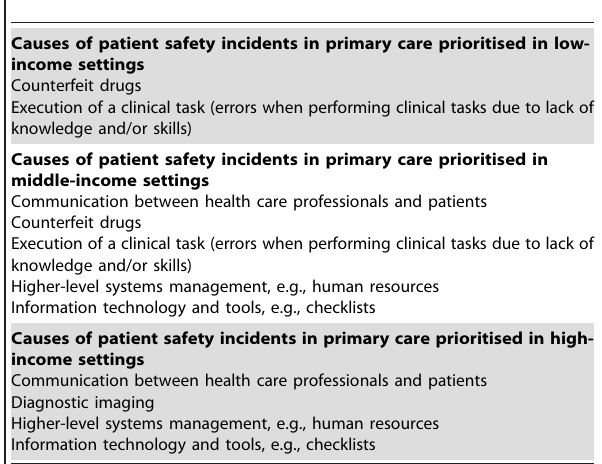
Table 5. Items relating to causes of patient safety incidents and associated harm that were considered to be important by over 80% of participants after round 3 in low-, middle-, and high-income settings.